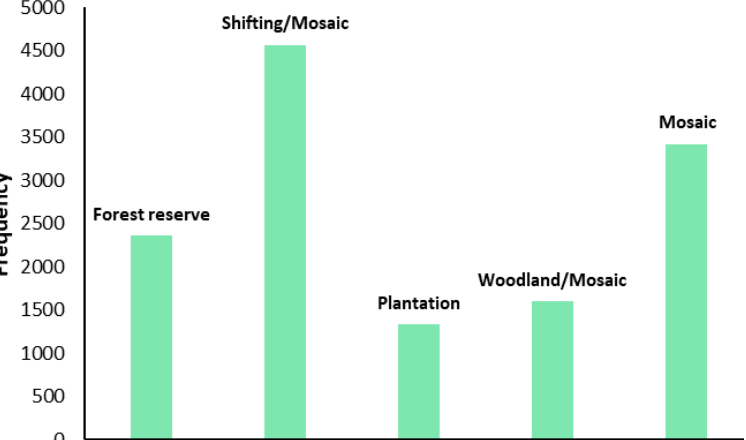
Figure 14. Greening trend for all three parameters for various land change dynamics.